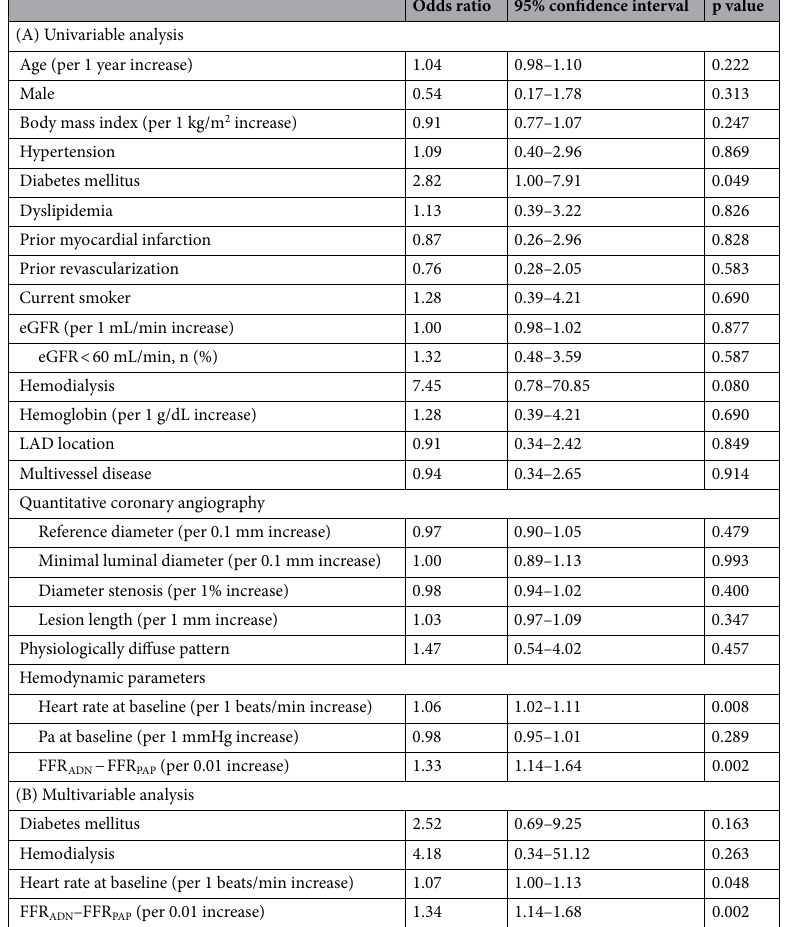
Table 3. Association with low resting Pd/Pa–high FFR ADN discordance. Values are expressed as medians (interquartile ranges) or numbers (percentages). eGFR estimated glomerular rate, FFR ADN fractional flow reserve value associated with adenosine, FFR PAP fractional flow reserve value associated with papaverine, LAD left anterior descending coronary artery, Pd/Pa distal-to-aortic pressure